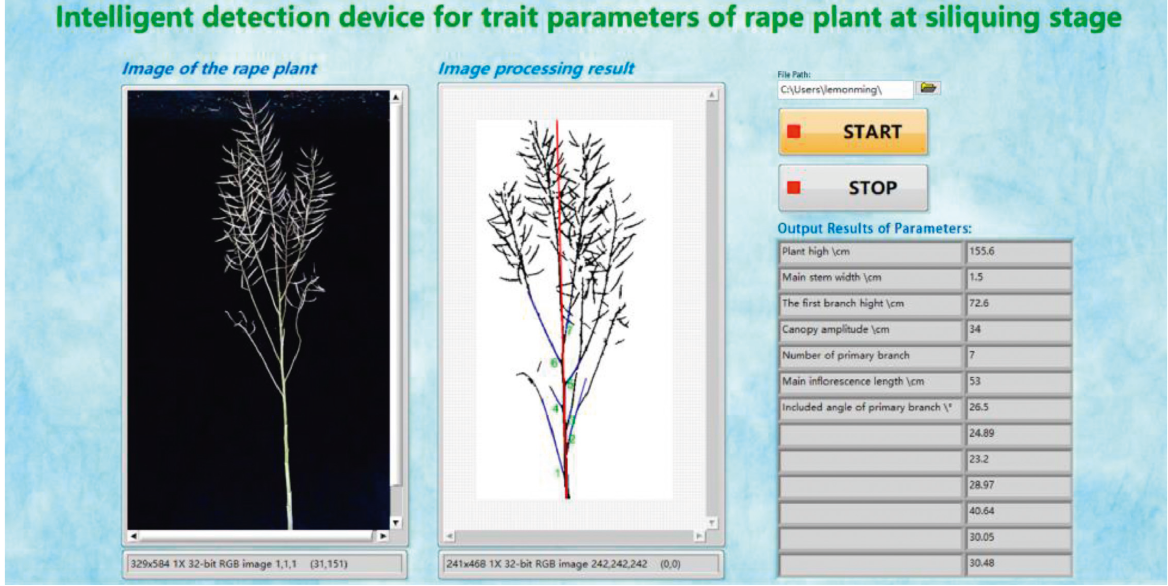
Figure 2: LabVIEW